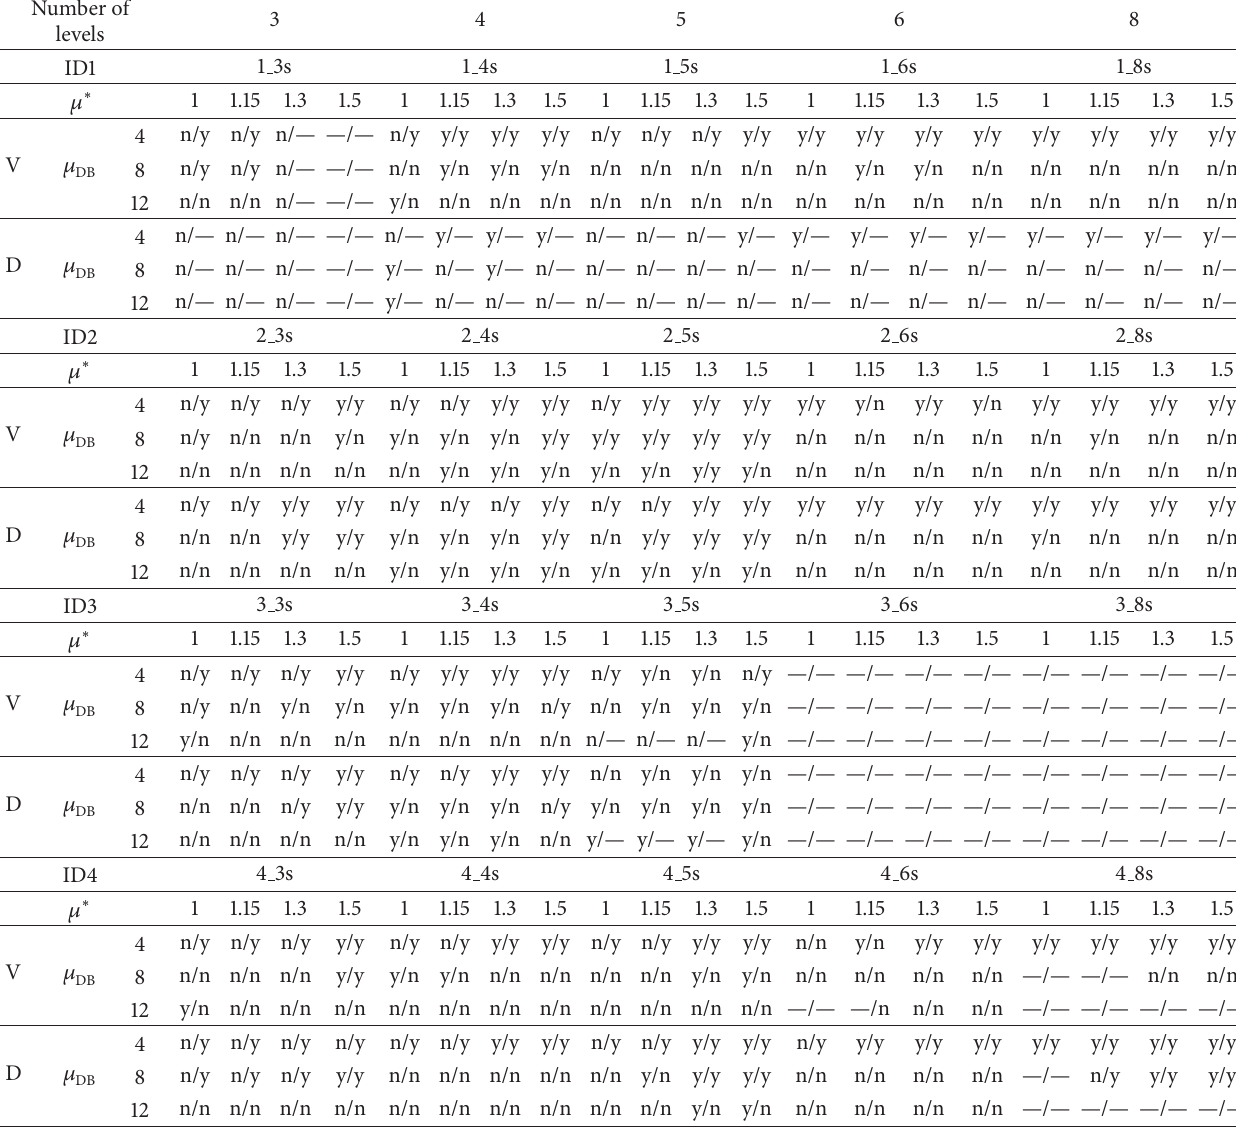
Table 5: Results of analysis on reinforced structures designed considering all cases Dir. 𝑋 /Dir. 𝑌